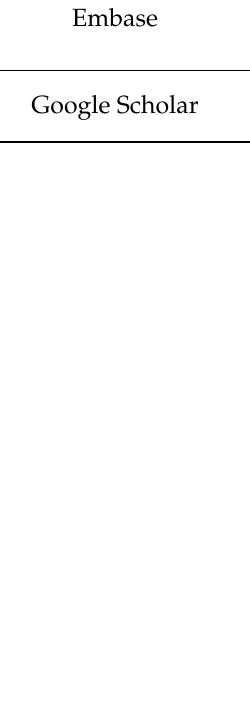
Table 2. Quality assessment results (Downs and Black